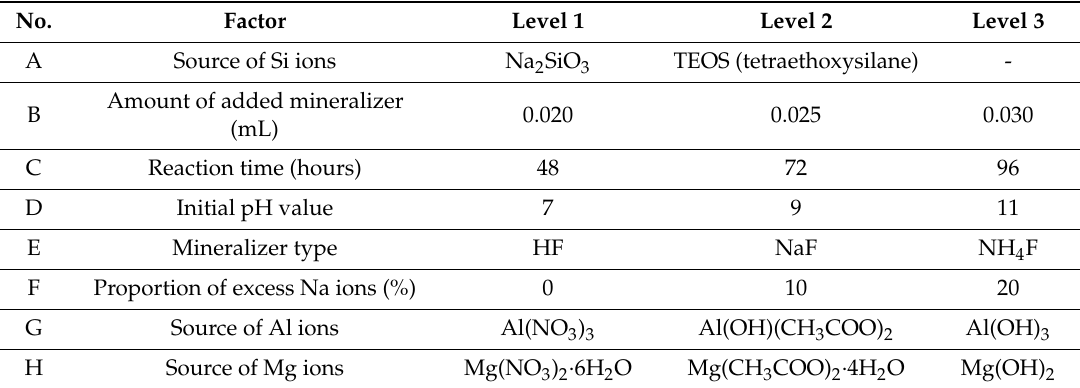
Table 2. Inner array for hydrothermally synthesized smectites with eight main factors. No. Factor Level 1